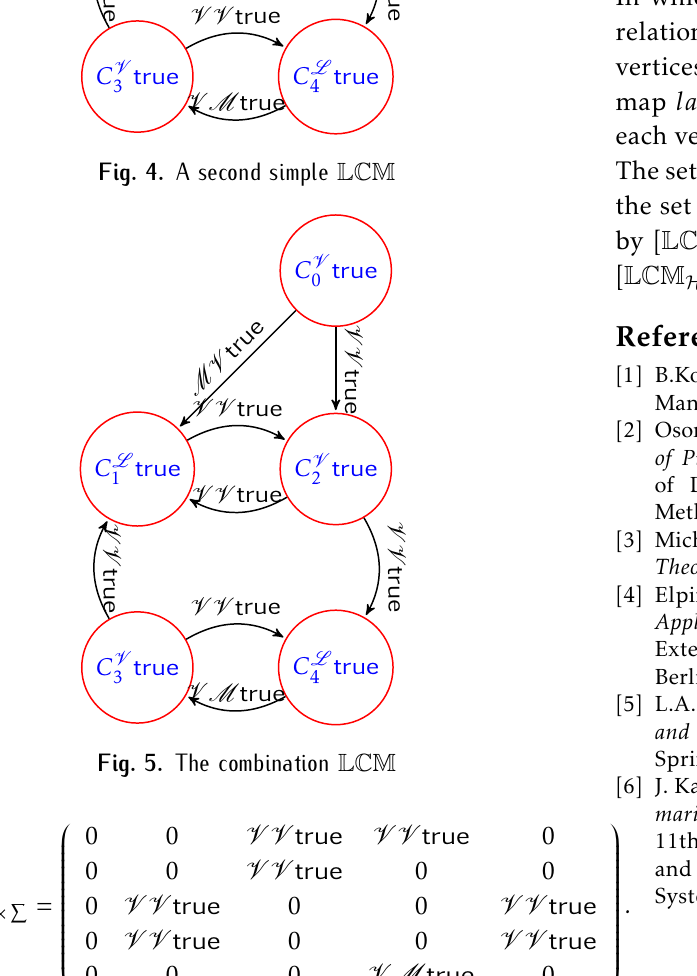
Fig. 5. The combination